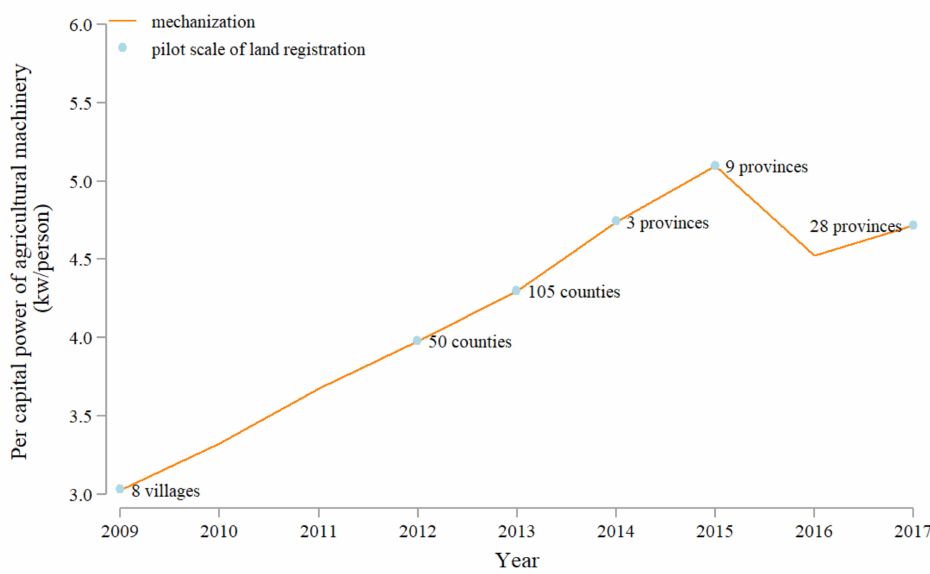
Figure 1. The relationship between land registration and agricultural machinery in China.